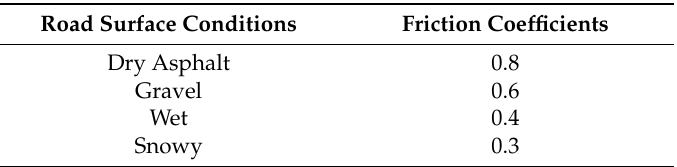
Table 1. Road friction coefficient and road surface condition.